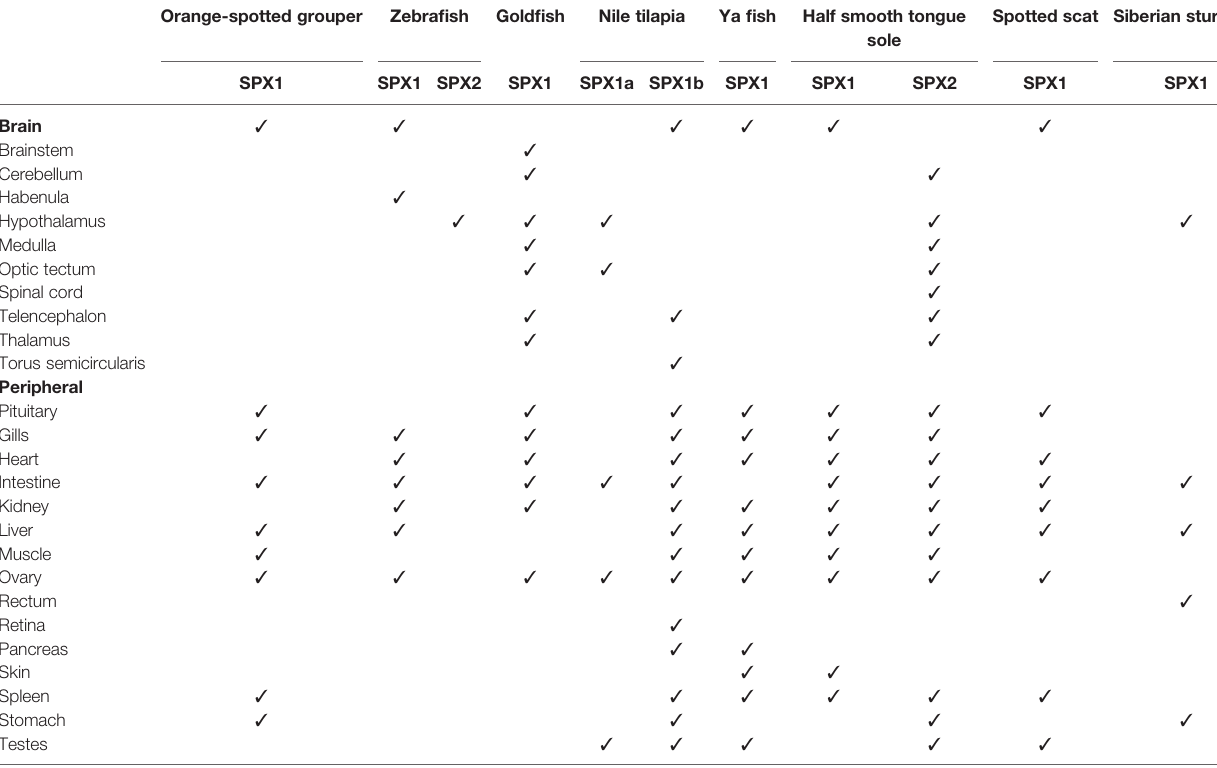
TABLE 3 | Distribution of SPX1 and SPX2 expression in the brain and periphery of fi sh